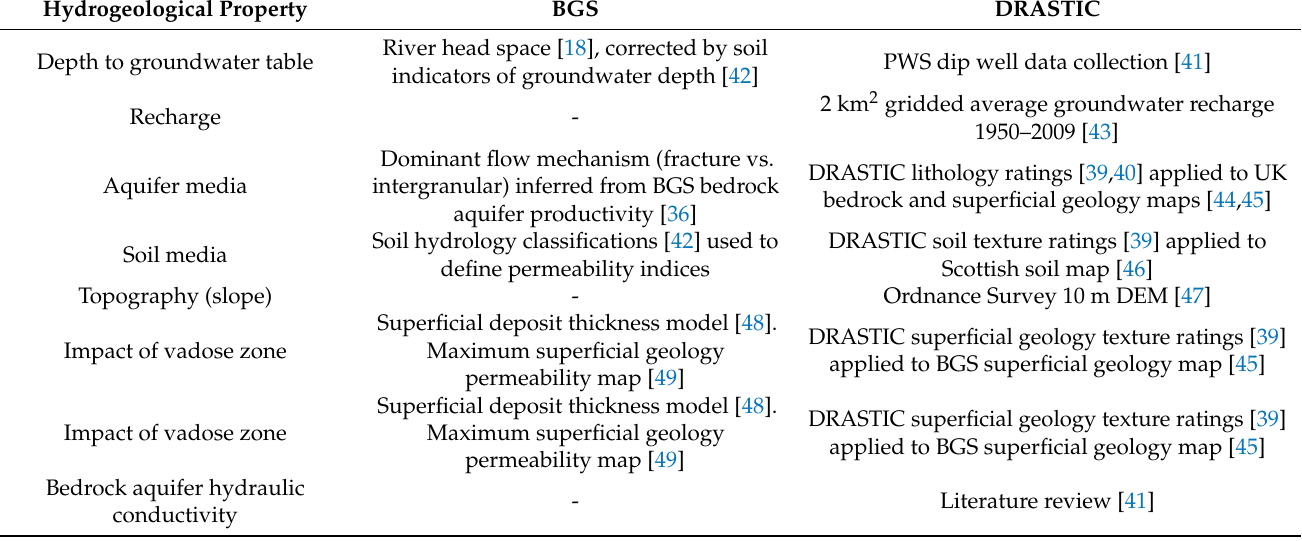
Table 2. Comparison of data sources for BGS and DRASTIC groundwater vulnerability map- ping approaches